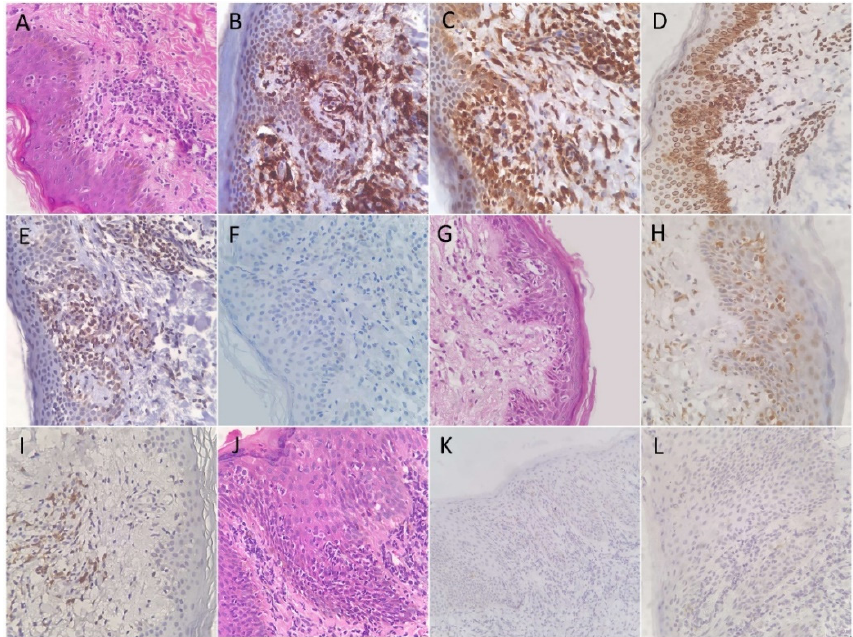
Figure 1. ( A ) Hematoxylin and eosin-stained histologic section from a patient with mycosis fungoides demonstrating atypical lymphocytes with enlarged hyperchromatic nuclei and clear perinuclear halos lining up the dermoepidermal junction and demonstrated epidermotropism. Most of atypical lymphocytes were positive for CD45RO ( B ) and TOX ( C ). ( D ) NFkB-P105/50 was positive in its cytoplasmic pattern, indicating an inactive form. JAK3 was also positive ( E ), while IL-17 was negative ( F ). Another patient of MF showing a positive expression of IL-17 ( G ). TOX was positive in few dermal lymphocytes but not in the epidermotropic lymphocytes ( H ). Patterns of immunohistochemical stains in mycosis fungoides ( I ). Histologic section from another patient of MF ( J ) that was negative for JAK3 ( K ) and IL-17 ( L ).